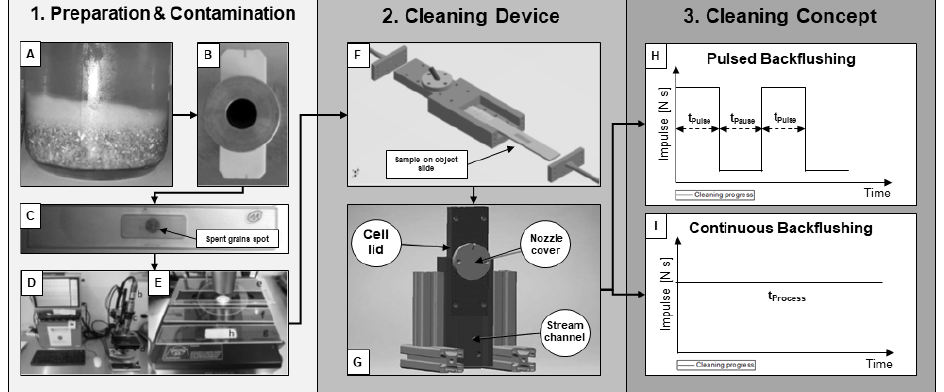
Figure 2. Illustration of the complete experimental procedure. ( A ) Prepared congress mash. ( B ) Alu- minum stencil on cloth sample. ( C ) Cloth sample in the object slide. ( D ) Digital microscope device. ( E ) Object slide under microscope lens, identifying contamination. ( F ) Insertion of object slide into cleaning device. ( G ) Final vertical positioning of the cleaning device. ( H , I ) Applied cleaning concept. This illustration concludes Sections 2.2–2.4.